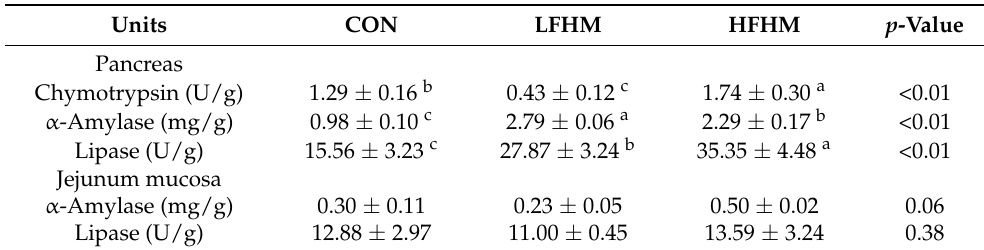
Table 4. Effects of different amounts of fermented Chinese herbal medicine on digestive enzyme activity of weaned piglets.